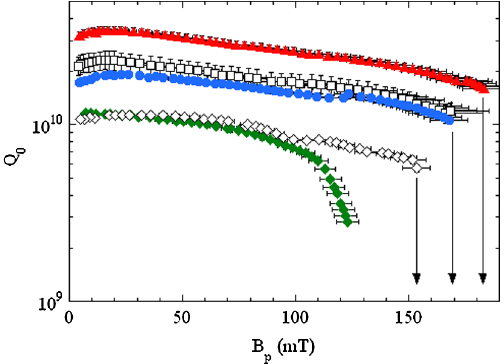
FIG. 8. (Color) Q vs B measured at 1.7 K after the baseline p 0 test (empty squares), after storing the cavity in air for four at 1 atm for 11 h (red triangles), months and filling with H 2 at 1 atm at 120 (cid:1) C for 12 h (blue after baking twice in H 2 squares), after heat treatment at 600 (cid:1) C for 10 h in UHV (green diamonds), and after baking at 120 (cid:1) C for 12 h in UHV (empty diamonds). The arrows indicate the quench fields in the various tests. There was no field emission in any of the